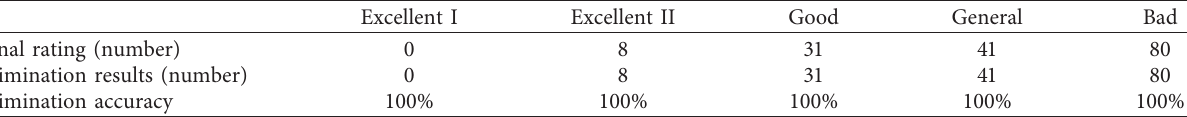
Table 5: Discrimination accuracy.